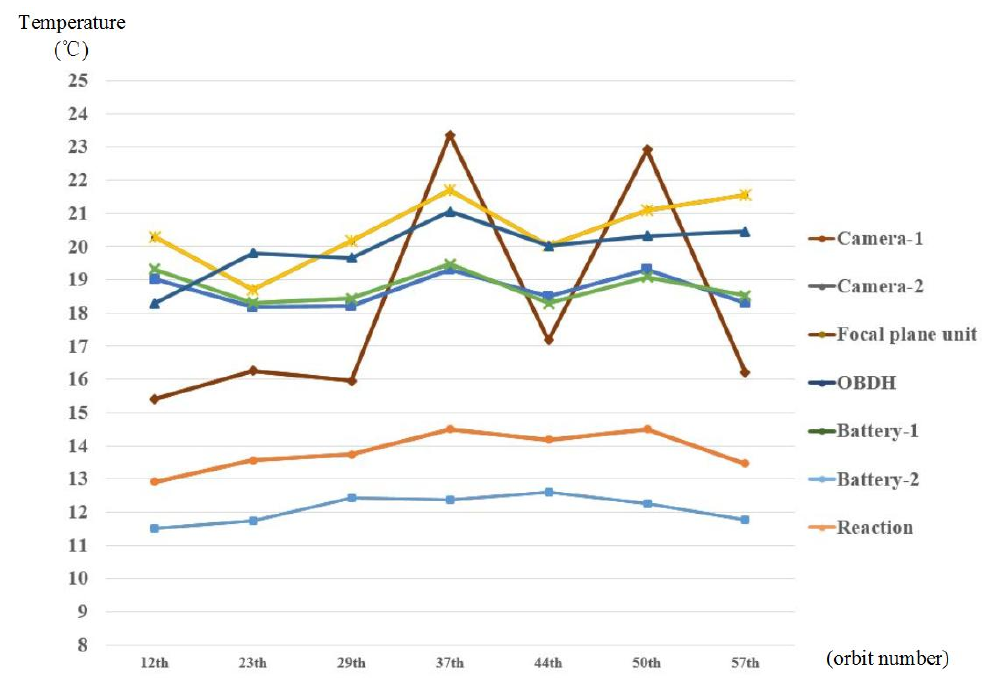
Figure 15. Temperature variation curve of the inside instruments on the Luojia 1-01.